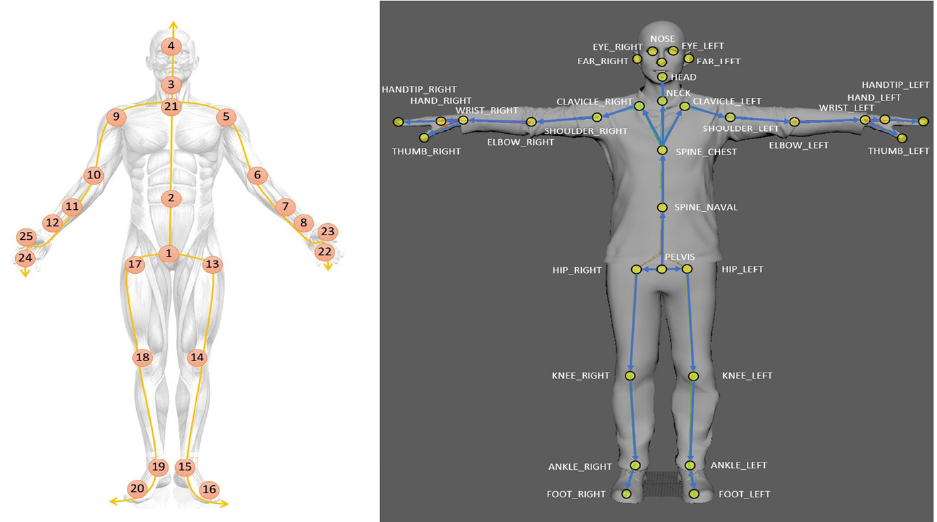
Figure 4. Joints acquired by Kinect v2 and Azure Kinect.